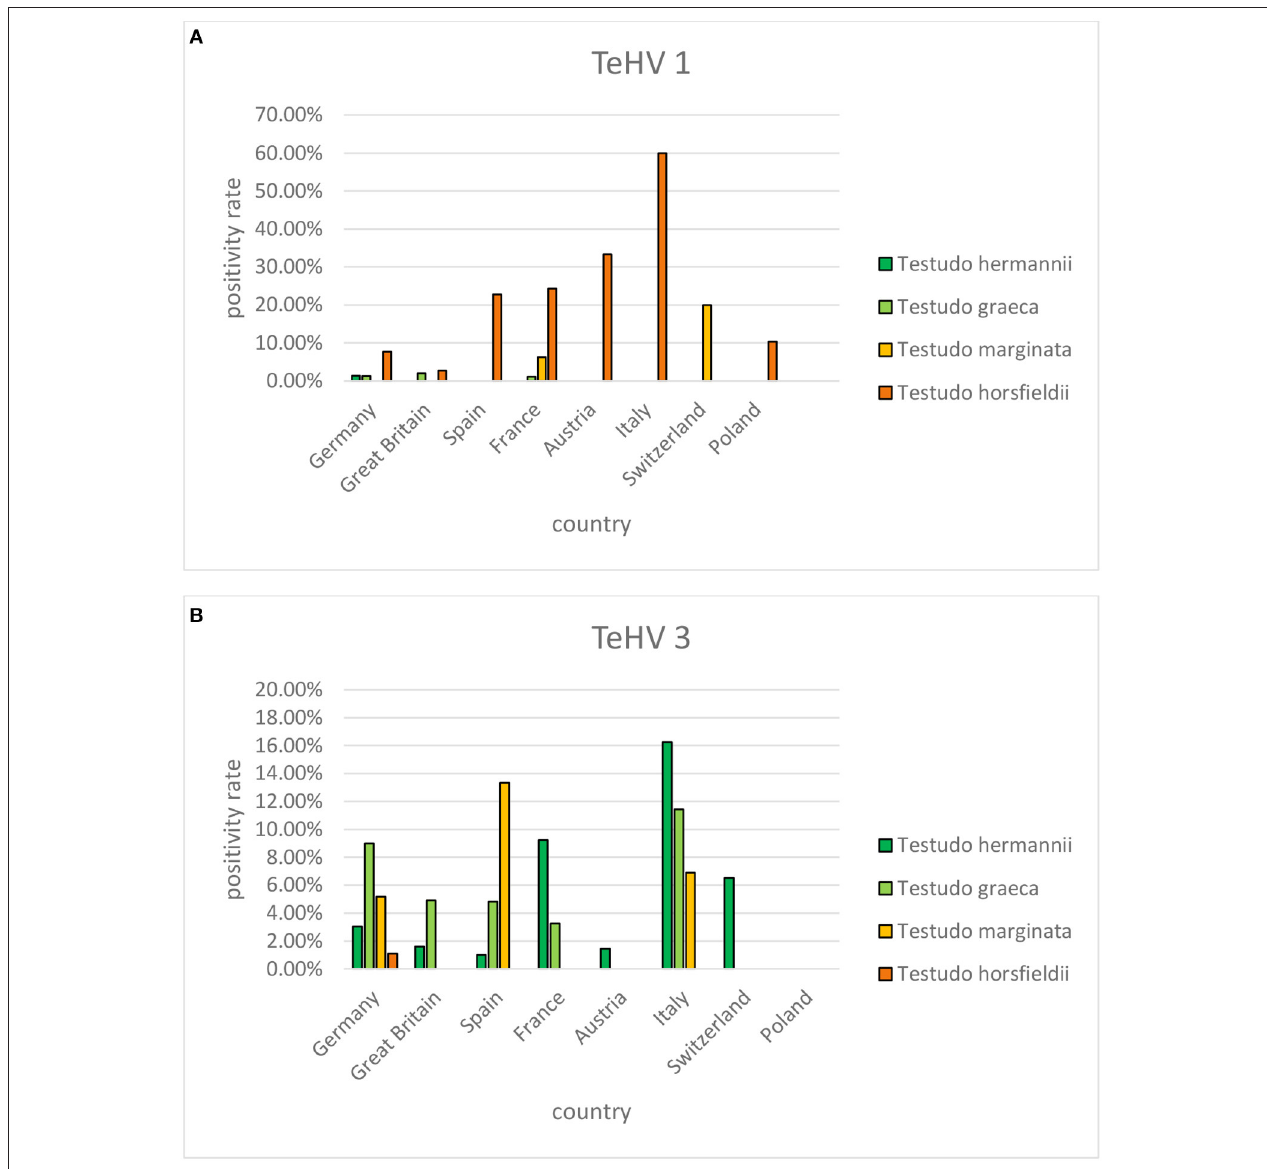
FIGURE 4 | Herpesvirus positivity rates in four Testudo species (Hermann’s tortoises, T. hermanni , spur-thighed tortoises, T. graeca , marginated tortoises, T. marginata , and Horsfield’s tortoises, T. horsfieldii) according to country for countries from which more than 100 samples were submitted ( A TeHV 1 and B TeHV 3).